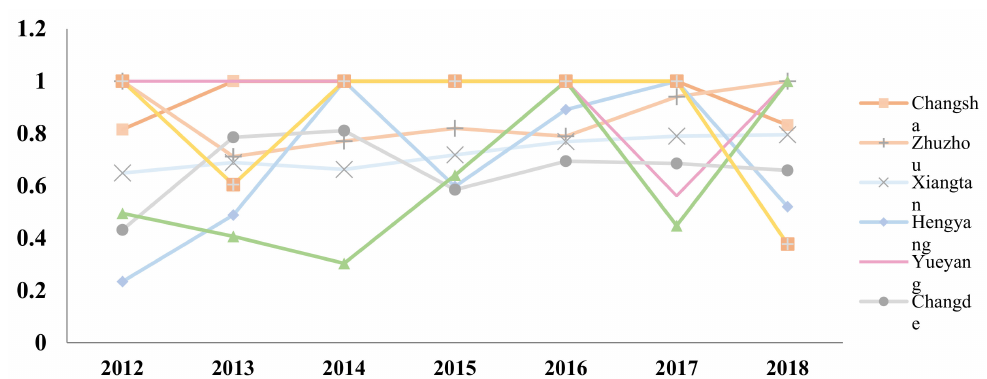
Figure 2. Distribution trend map of green innovation efficiency in the urban agglomeration.